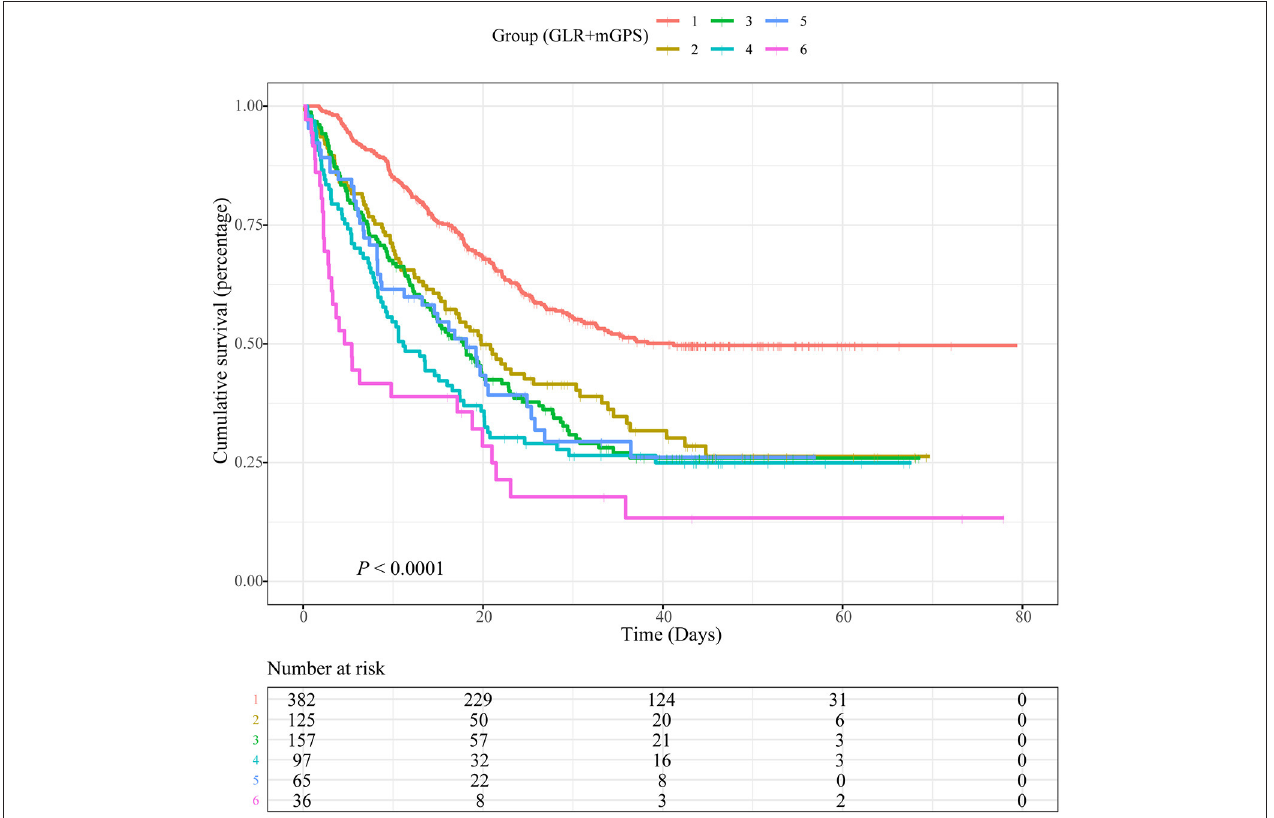
FIGURE 3 | Kaplan-Meier curves showing associations between a combination of blood glucose to lymphocyte ratio (GLR) and modified Glasgow prognostic score (mGPS) and overall survival (OS) in patients with non-small cell lung cancer (NSCLC). Group 1: Low GLR and mGPS = 0; Group 2: High GLR and mGPS = 0; Group 3: Low GLR and mGPS = 1; Group 4: High GLR and mGPS = 1; Group 5: Low GLR and mGPS = 2; Group 6: High GLR and mGPS =